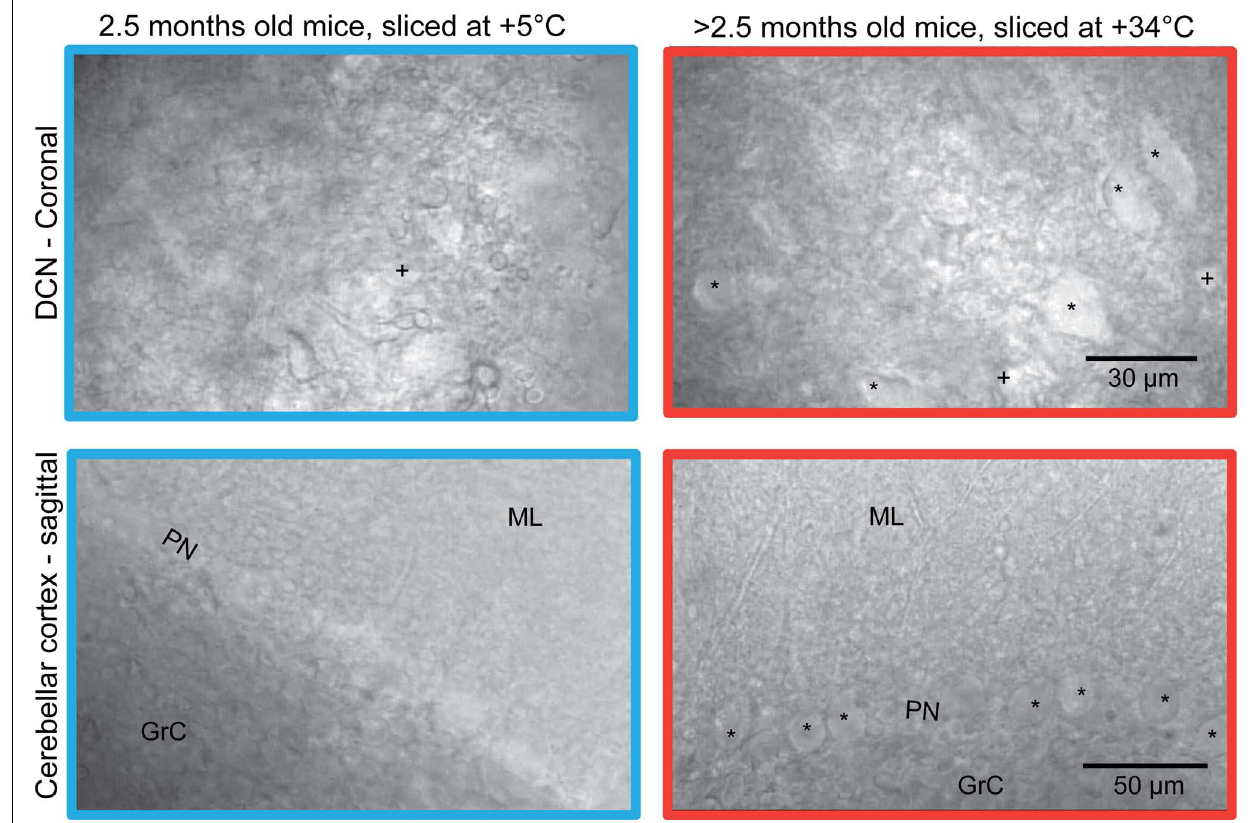
FIGURE 1 | Comparison of the surface of acute coronal (top) and sagittal (bottom) mice (strain C57BL/6J 6w) cerebellar slices prepared with ice-cold (left) and warm (right) preparation methods. Patchable cells are indicated. All slices shown were prepared from mice aged 2.5 months, except for the sagittal slice cut at warm temperature (lower right) which was prepared from a 6-month old mouse. Note that in the warm-cut coronal slice,